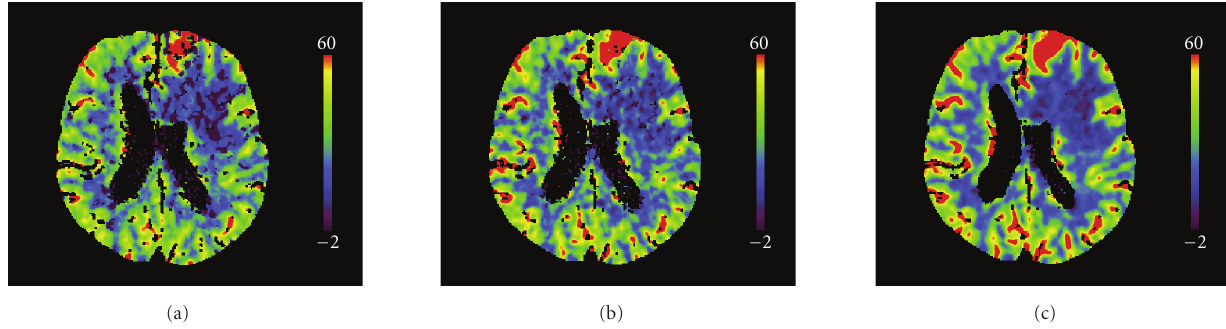
Figure 11: Cerebral blood flow maps computed from the original sequence (a), sequence 4 ( T s = 4 s), (b) and sequence 1 ( T s = 1s) (c).